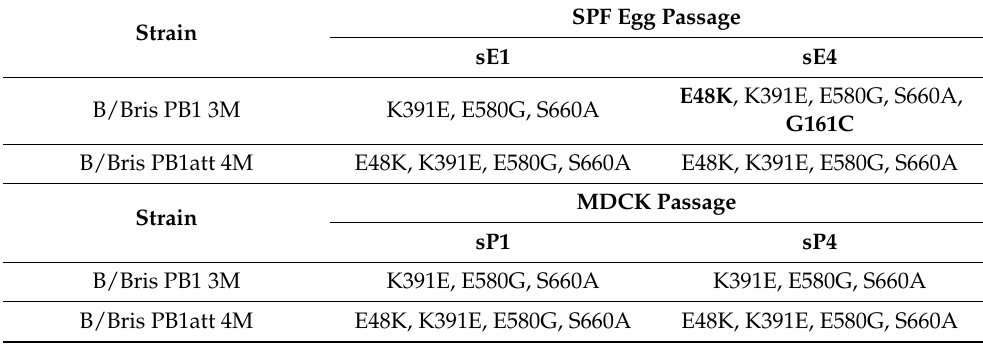
Table 1. Evaluation of genetic stability in the PB1 gene of B/Bris PB1 3M and B/Bris PB1att 4M strains after serial passage in MDCK cells and SPF eggs. Newly acquired mutations during the serial passages that were not introduced via reverse genetics are highlighted in bold. All mutations were confirmed by Sanger sequencing. sE1 and sE4 represent the 1st and 4th serial passage in SPF eggs, respectively. sP1 and sP4 represent the 1st and 4th passage in MDCK cells,